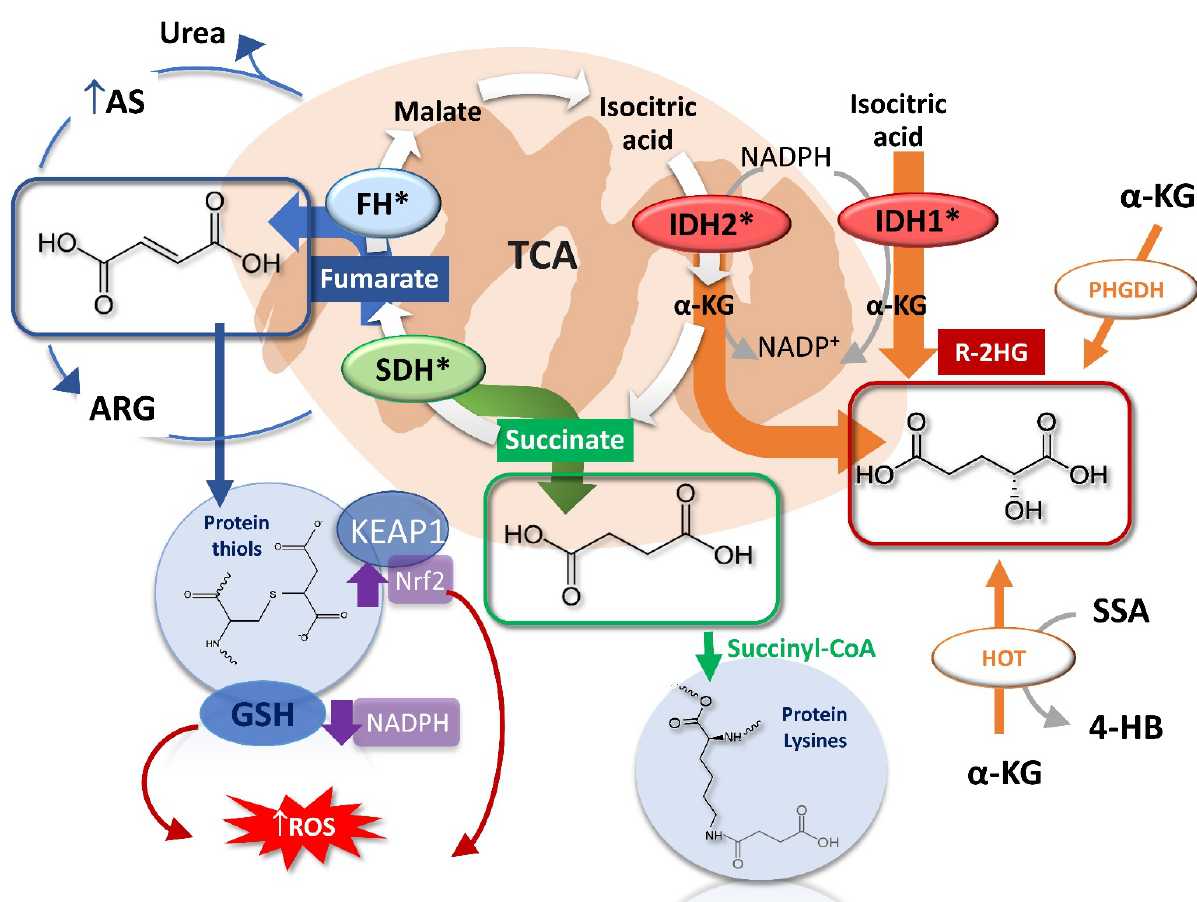
Figure 1. Oncometabolites production and reactions. Loss of function of mutated SDH and FH enzymes leads to the accumulation of succinate and fumarate that triggers post-translational proteins modifications such as succinylation and succination, respectively. The R-2HG derives mainly from the neomorphic catalytic activity of the mutated mitochondrial IDH2 and cytosolic IDH1, and less from non-canonical reactions involving the PHDGH and HOT enzymes. FH, fumarate hydratase; SDH, succinate dehydrogenase; α - KG, α -ketoglutarate; R-2HG, R-2-hydroxyglutarate; PHDGH, phosphoglycerate dehydrogenase; HOT, hydroxyacid-oxoacid-transhydrogenase; 4-BH, 4- hydroxybutyrate; SSA, succinic semialdehyde; AS, argininosuccinate; ARG, arginine.